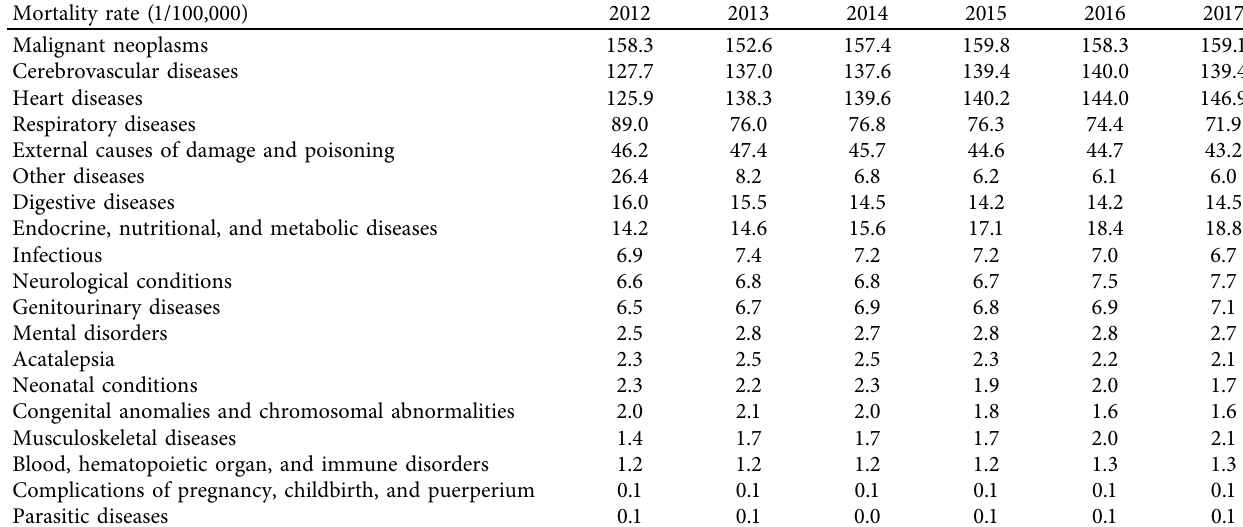
Table 2: Demographic mortality statistics in China based on Chinese